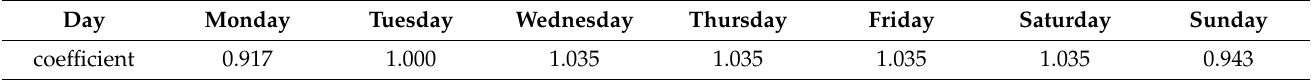
Table 7. Hourly coefficients representing the operation of commercial kitchens in Attica